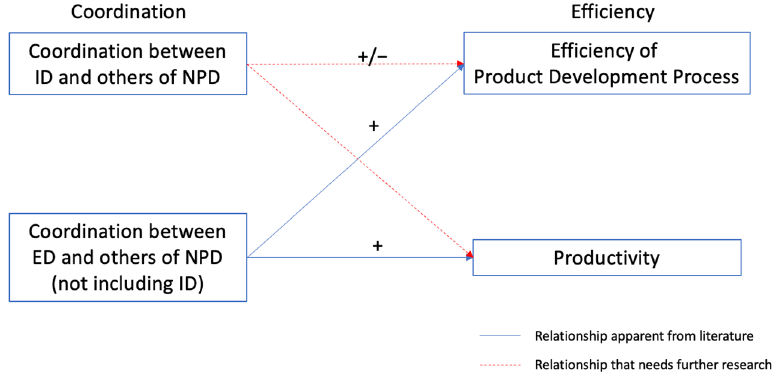
Figure 3. Relationship between coordination and efficiency Source : Created by the author from Chiva-Gomez (2004), Clark and Fujimoto (1991), Itohisa (2012), Perks, Cooper, and Jones (2005), Thomke and Fujimoto (2000), and Zhang, Hu, and Kotabe